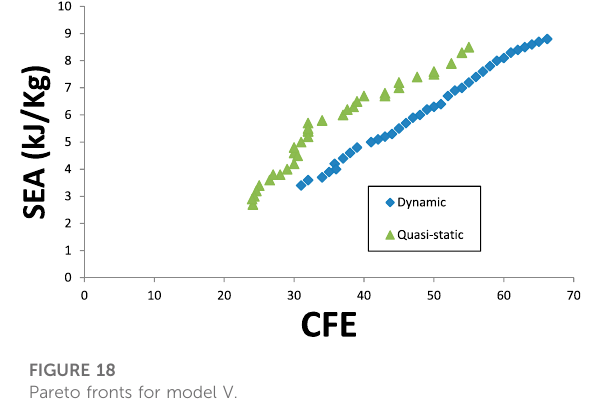
FIGURE 18 Pareto fronts for model